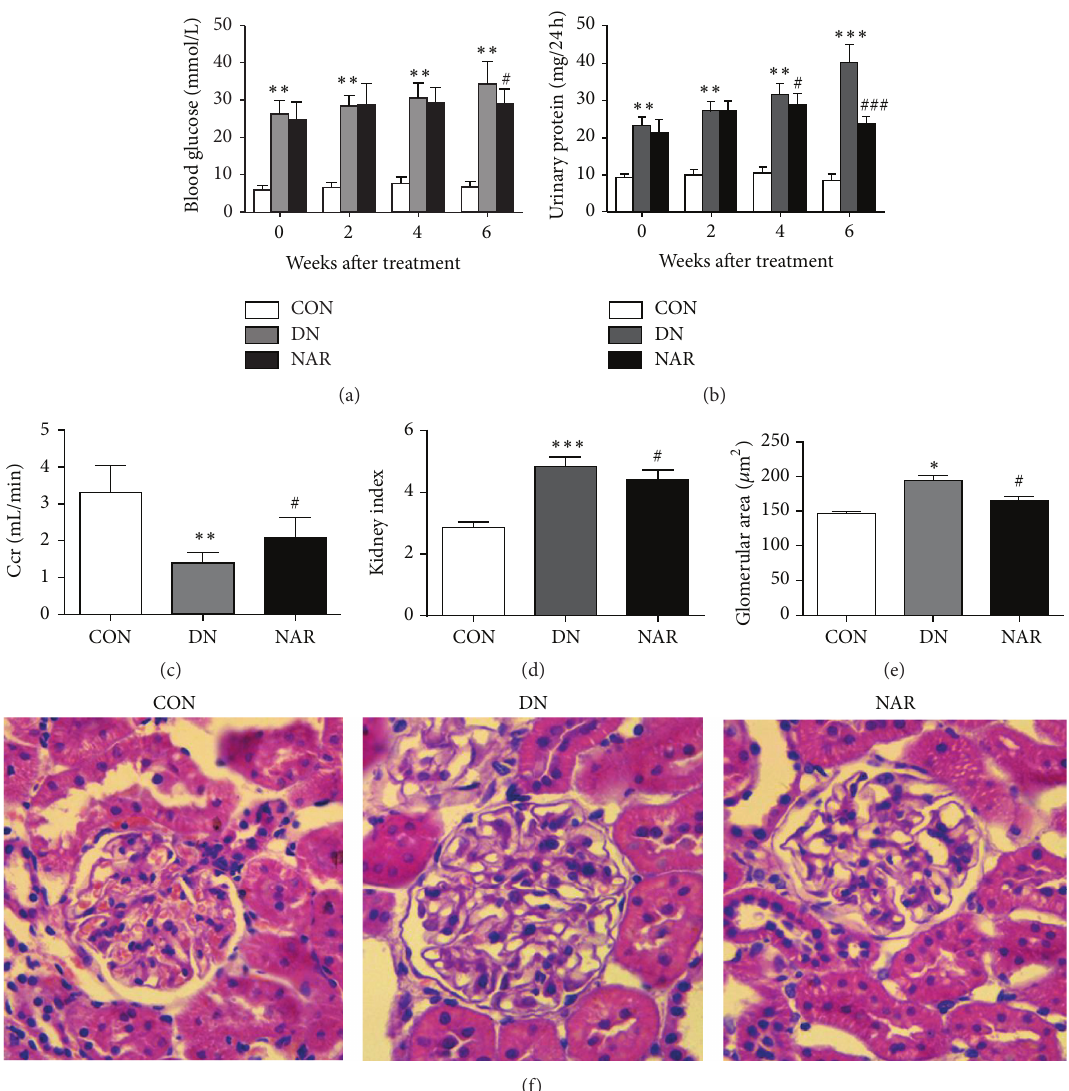
Figure 1: Effects of NAR on renal morphology and functions in diabetic rats. (a) Blood glucose level, (b) 24 h urinary protein, (c) urinary creatinine clearance ratio (Ccr), (d) kidney index (KI) which equals right kidney weight/body weight × 1000, (e) glomerular area (GA), and (f) representative photograph for hematoxylin-eosin (HE, × 400) are shown. Results are expressed as mean ± standard deviation, CON ( 𝑛 = 5 ), DN ( 𝑛 = 7 ), and NAR ( 𝑛 = 8 ). (a–d) ∗ 𝑝 < 0.05 , ∗∗ 𝑝 < 0.01 , and ∗∗∗ 𝑝 < 0.001 versus CON group; # 𝑝 < 0.05 , ## 𝑝 < 0.01 , and ### 𝑝 < 0.001 versus DN